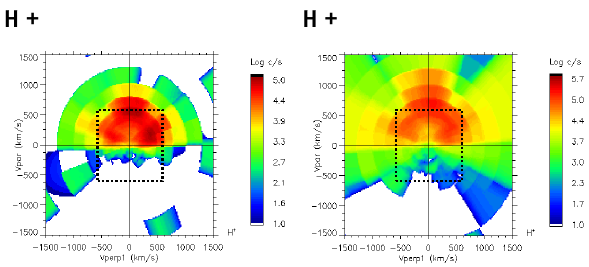
Fig. 6. H + ion velocity distributions in counts per second (c/s) ob- served by the Cluster S/C-1 at 07:23:18 UT (left) and the Cluster S/C-3 at 07:23:22 UT (right) on 14 April 2001. There was a 4-s time interval between two spacecraft, but as shown in the velocity distributions, the Cluster S/C-1 was presumed not to be in the day- side cusp due to little down-going population compared to the right